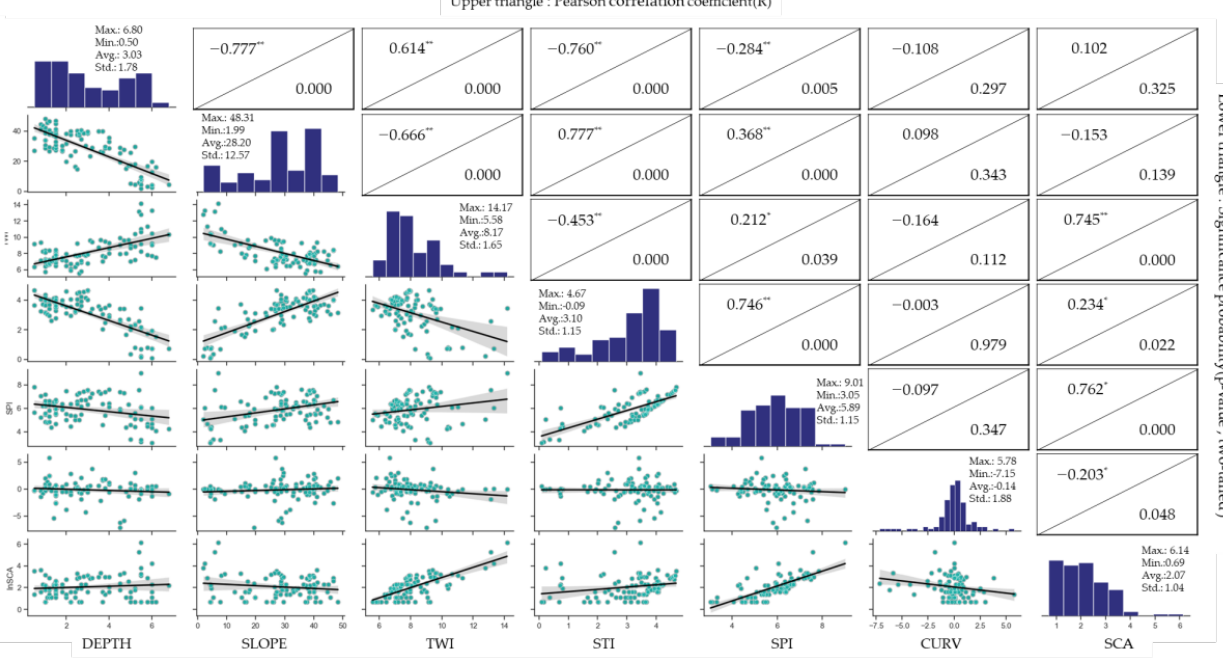
Figure 5. Correlation coefficient for Sedimentary rock (*: Significant at the 0.05 probability level. **: Significant at the 0.01 probability level).